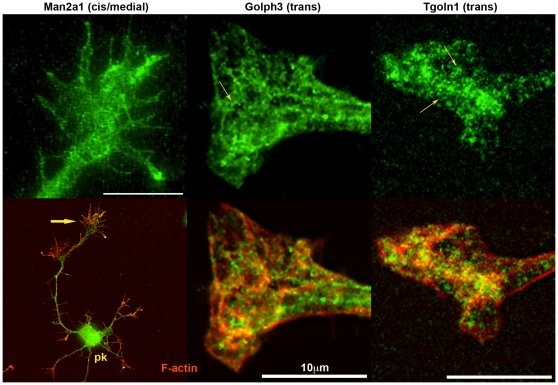
Hippocampal pyramidal neurons and/or their axonal growth cones labeled with antibodies to Golgi proteins (top row).The antibody specificities are indicated above. cis/medial/trans, known Golgi location of the antigens. pk, neuronal perikaryon; large arrow, axonal growth cone; small arrows, reticular structures.